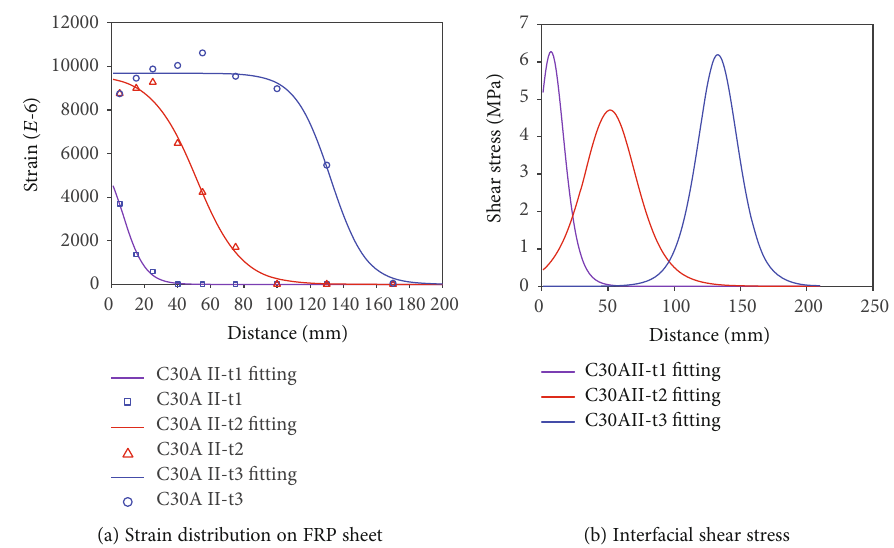
Figure 6: Nonlinear fi tting for the interfacial strain distribution and shear stress.